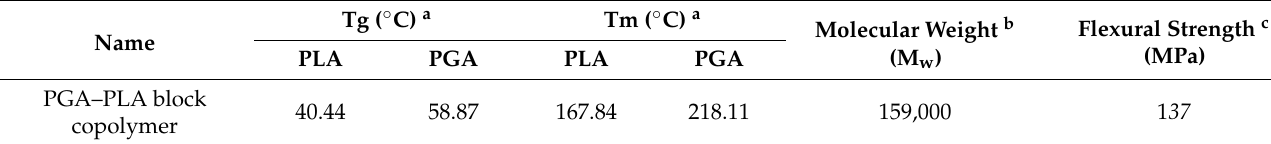
Table 1. Characterization of PGA–PLA block copolymer.